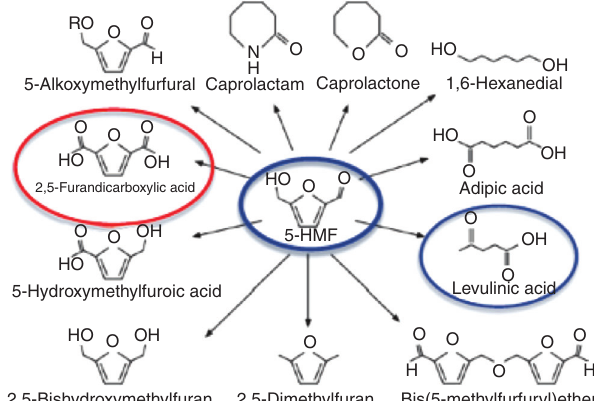
Figure 1 Potential applications for